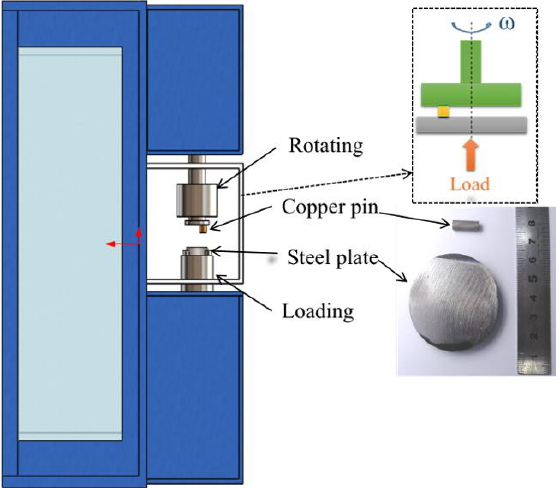
Figure 3. The MMW-1 friction and wear tribometer, and the settlement of specimens.